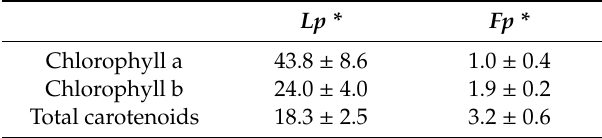
Table 2. Chlorophyll and carotenoid contents of Elaeagnus angustifolia fruits and leaves.